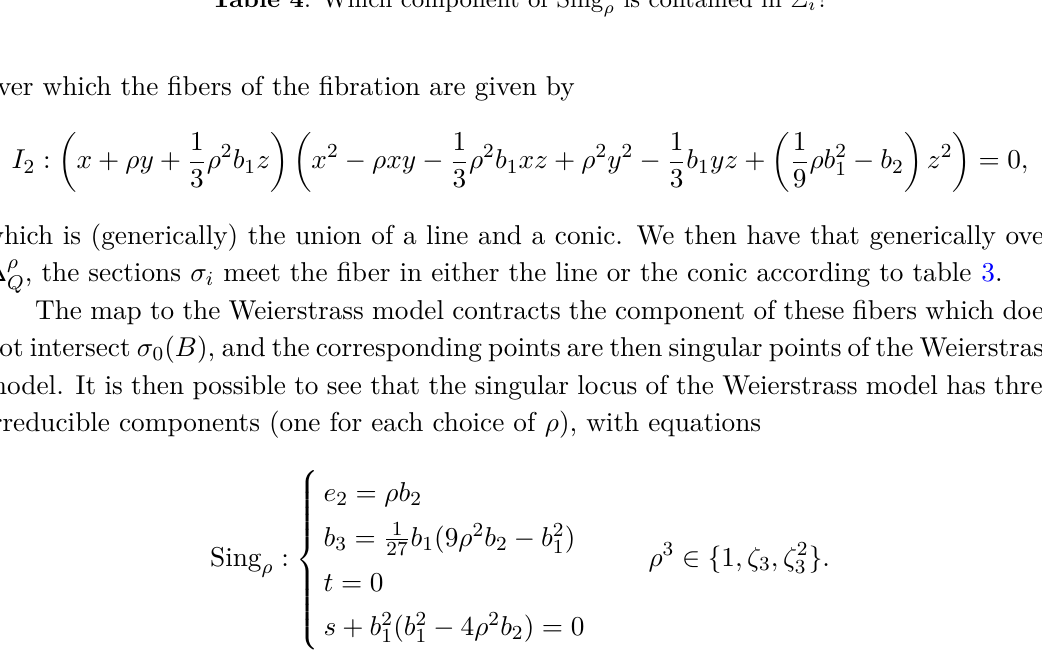
Table 4 . Which component of Sing